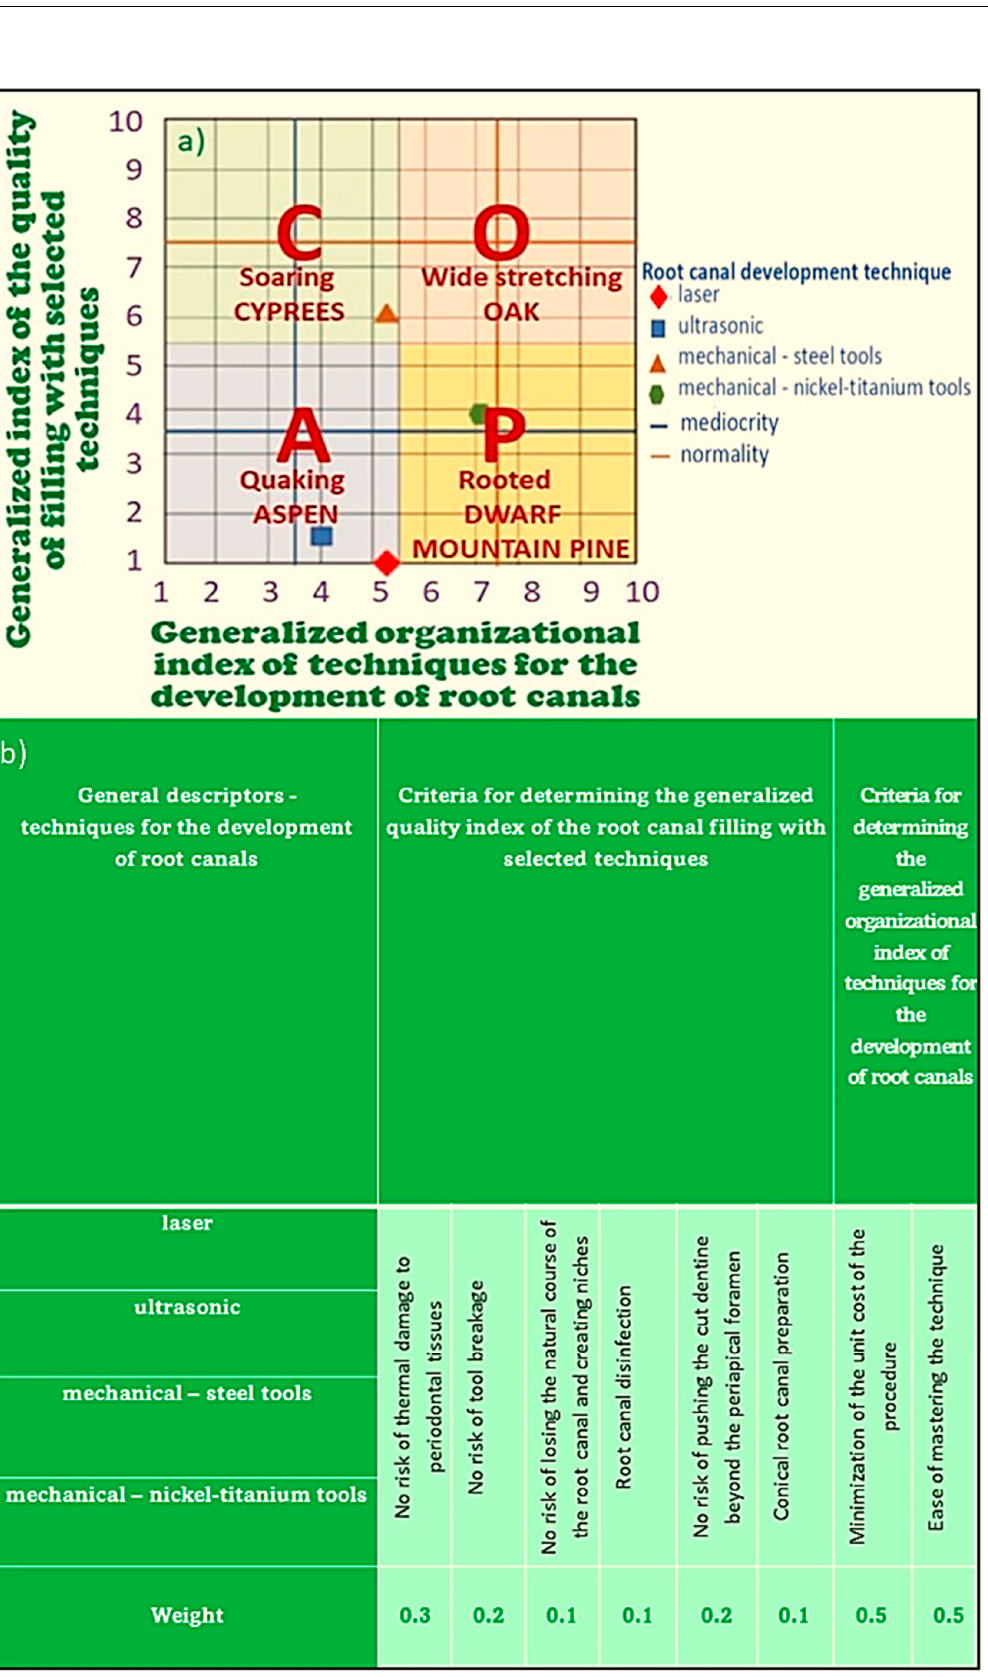
Figure 10. Contextual matrix of attractiveness of ( a ) virtual contextual analysis regarding methods of root canal preparation and a set of adopted criteria for expert assessment ( b ).